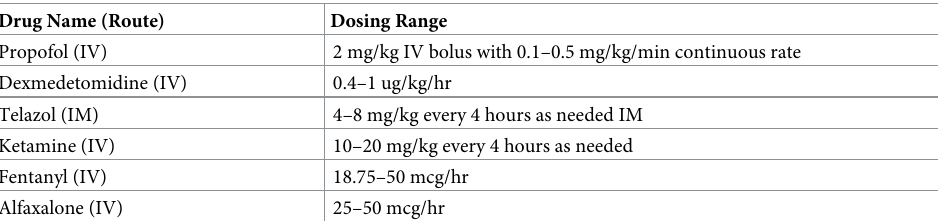
Table 1. Sedation and analgesia regimens and